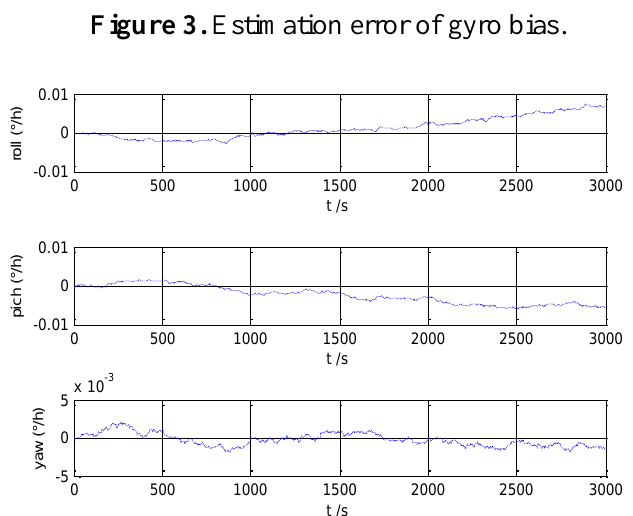
Figure 3. Estimation error of gyro